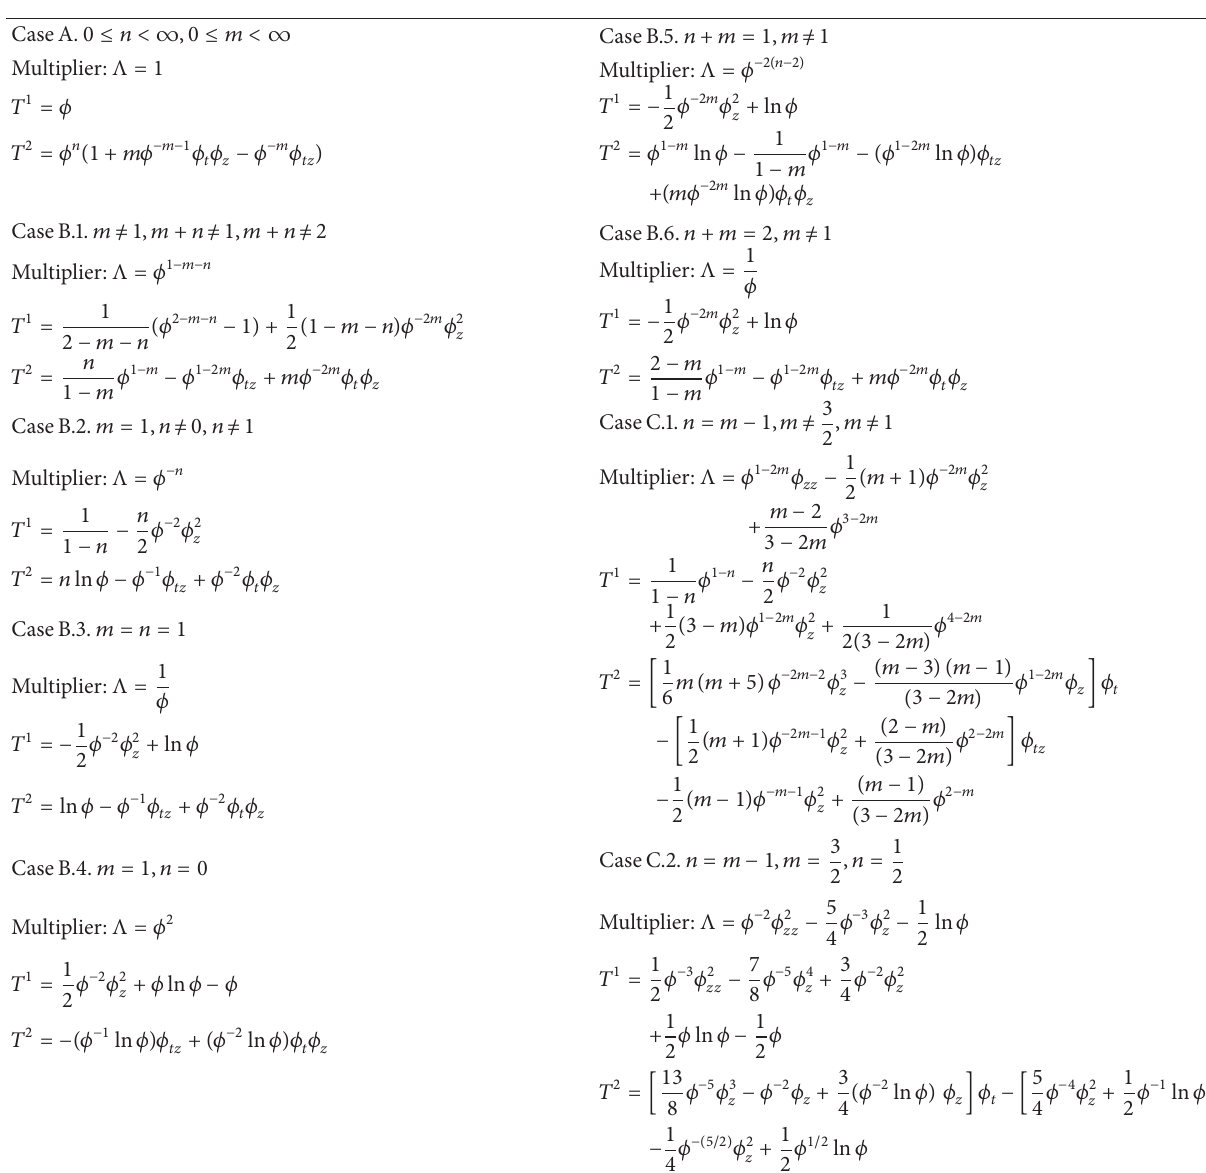
Table 1: Multipliers and conserved vectors for the partial differential equation